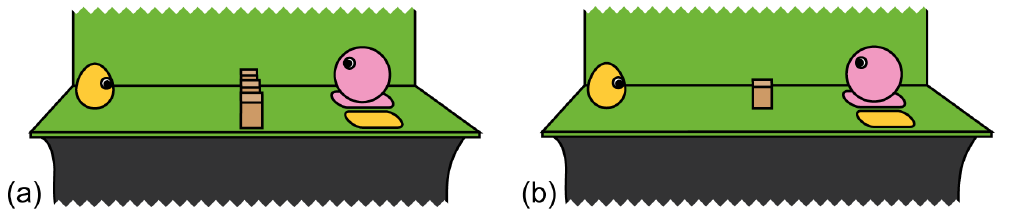
Figure 2. Mean percentage of trials participant moves agent beyond barrier, by condition. Error bars show one standard error.